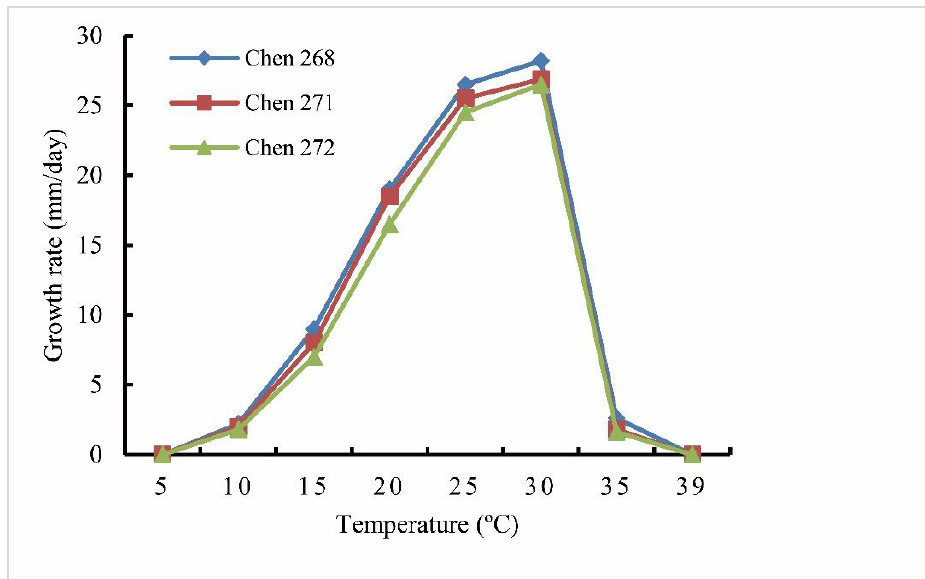
Figure 4. Mycelial growth rate of Globisporangium tenuihyphum isolates Chen 268, 271, and 272 on potato carrot agar at different temperatures.